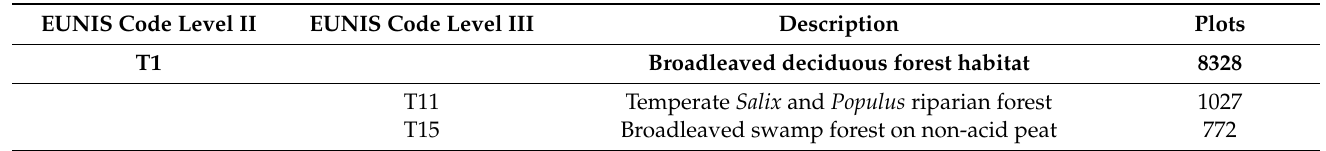
Figure 1. Overview of the study area showing location of PhenoCam sites used for validation and the spatial distribution of forest types plots classified using EUNIS level II classification (T1: broadleaved deciduous forest; T2: broadleaved evergreen forest; T3: needleleaved evergreen forest and, T34: needleleaved deciduous forest). PhenoCam data source: https://phenocam.sr.unh.edu/webcam (accessed on 11 March 2021). Table 1. Forest types selected according to EUNIS II and III level classification